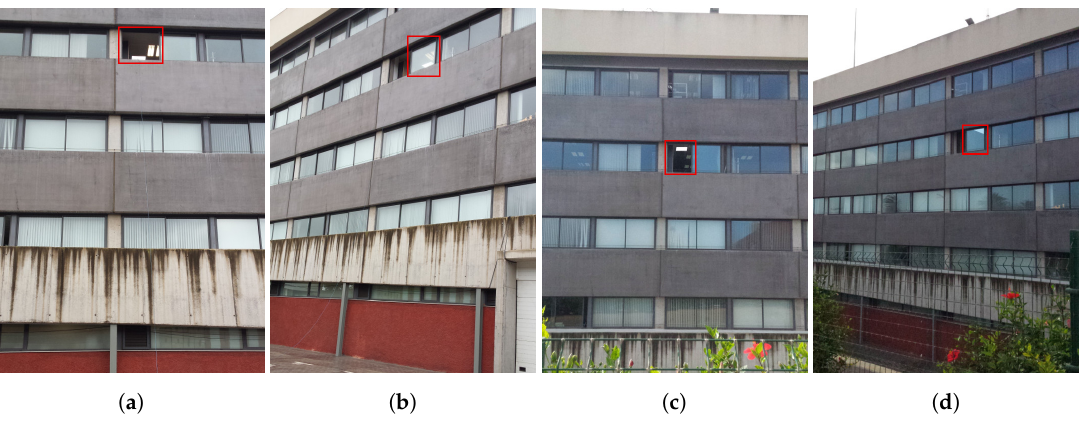
Figure 8. Pictures of the target emitter from the diferent locations where the sniffer was positioned: ( a ) T1; ( b ) T2; ( c ) T3; and ( d ) T4 as defined in Table 2. In ( b , d ), it can be observed that the double panel window is between the emitter and the receiver. In ( a , c ), the receiver has a clear and direct view without obstacles of the emitter; and the window in which the emitter can be observed is highlighted in red.